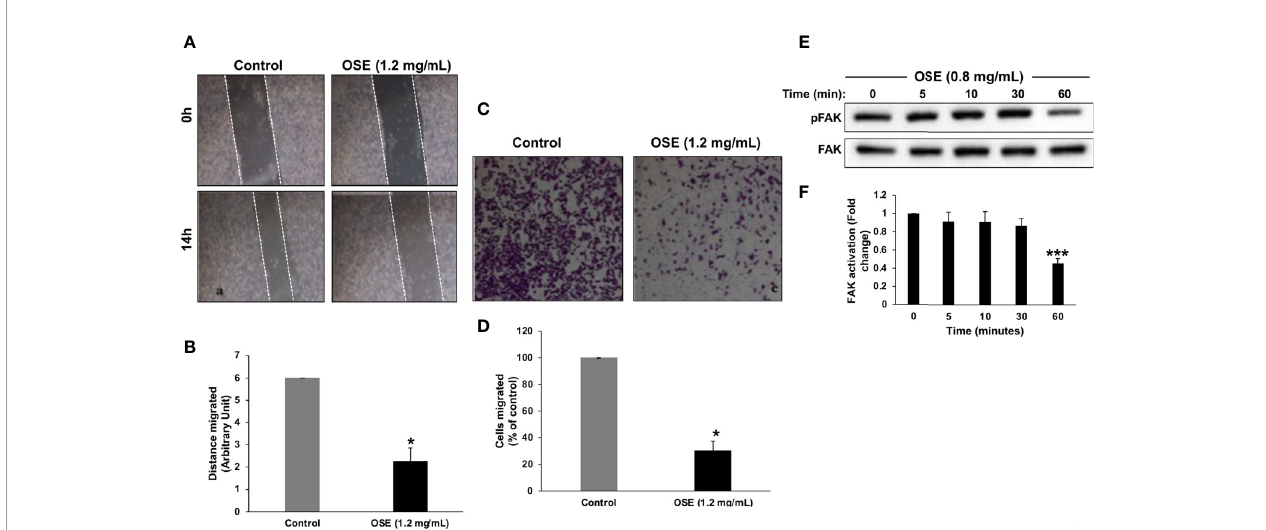
FIGURE 3 | OSE inhibits migration and downregulates activated FAK in MDA-MB-231 cells. (A, B) Cells were treated with OSE (1.2 mg/ml) and cell migration was assessed by wound healing assay. (C, D) Inhibition of cell migration in transwell migration assay. Images of crystal violet-stained migratory cells were taken 6 h post- treatment. Values are represented as mean ± SEM of distance migrated (n = 3 replicates) (*p < 0.05). (E) Downregulation of pFAK by OSE. Cells were treated with OSE (0.8 mg/ml) for 5, 10, 30 and 60 mins, and the phosphorylation level of FAK was determined by Western blotting. (F) Quantitation of three independent replicates plotted as mean of fold change (***p <